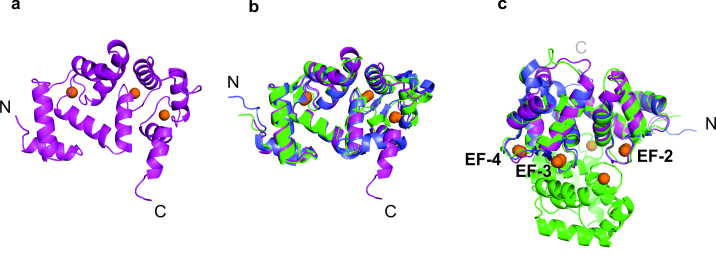
Cartoon representation of the crystal structure of the wild-type hippocalcin and its comparison with the structures of other calcium-binding proteins. (A) Wild-type human hippocalcin (magenta) with 3 Ca2+ ions (orange spheres) bound at EF-2, EF-3 and EF-4 sites. Alignment of human hippocalcin crystal structure (magenta) with (B) rat NCS-1 (blue) (PDB 5AEQ) and bovine neurocalcin delta (green) (PDB 1BJF), revealing a different orientation of the C-terminal region of the molecule; (C) rat NCS-1 (blue) (PDB 5AEQ) and dimeric bovine neurocalcin delta (green) (PDB 1BJF), showing structural conservation of the EF-hands, located at the dimerization interface.